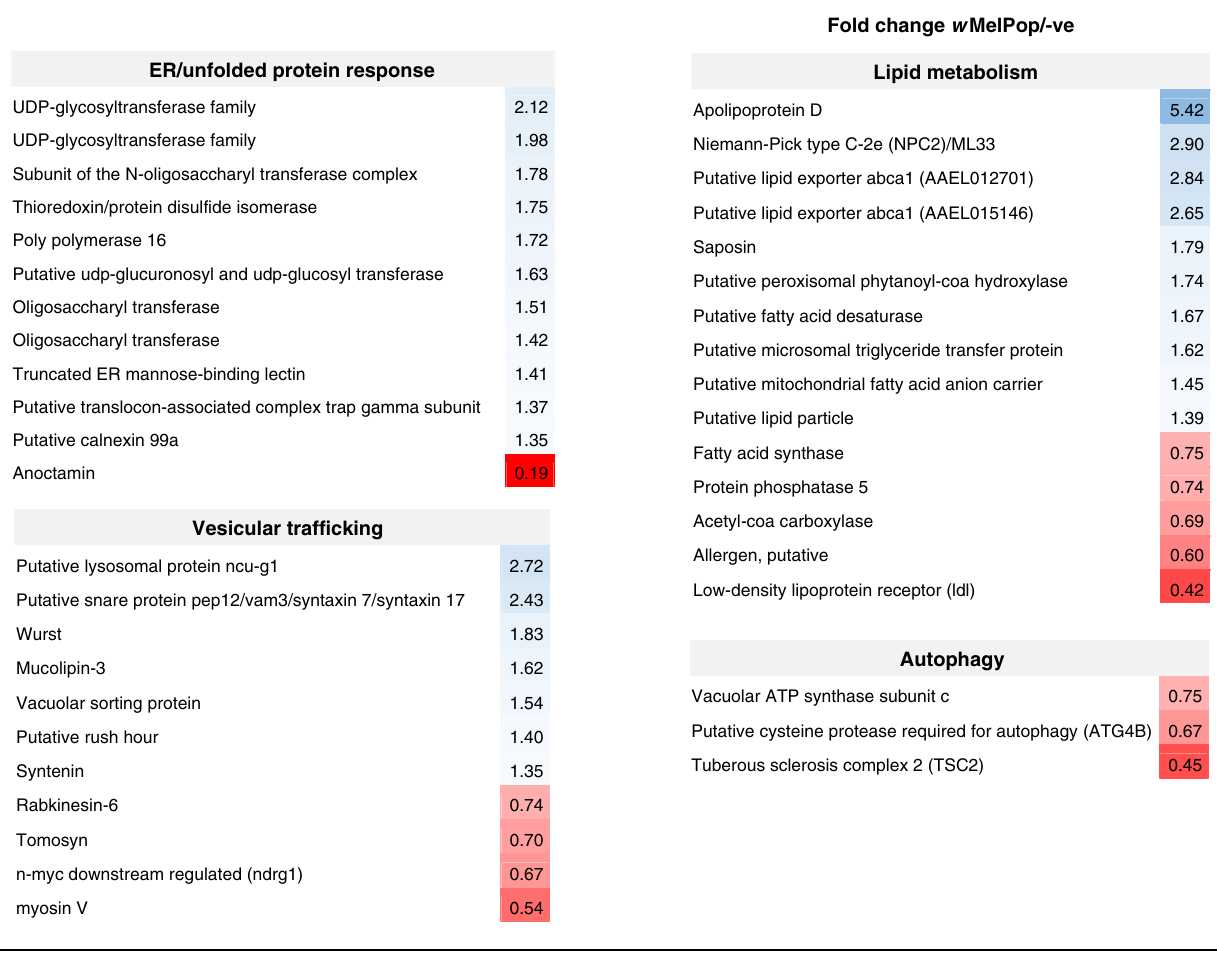
ER/unfolded protein